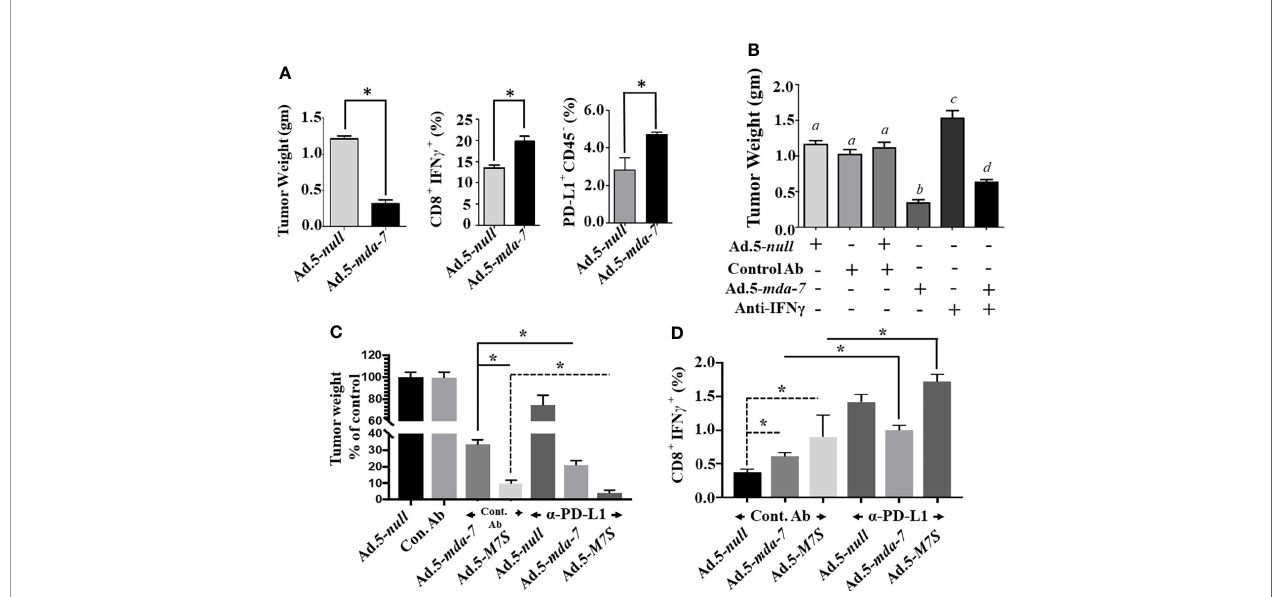
FIGURE 8 | Ad.5- M7S and anti-PD-L1 synergistically suppress murine B16 melanoma xenograft growth. (A) (Left Panel), Effect of MDA-7/IL-24 on B16 tumor growth in C57BL/6 animals. 5 X 10 5 B16 cells were injected subcutaneously in C57BL/6 mice and infected with Ad.5- null or Ad.5- mda-7 (intratumoral injection 10 8 viral particles, 3X in a week, 6 injections in total). Tumor weight was measured. Data presented is the average weight on day 14 from 5 mice from each group. Middle Panel, Cytotoxic T cell accumulation in the tumor. Right panel, PD-L1 expression in the cells isolated from tumors treated with Ad.5- mda-7 . Immunostaining protocol is described in Materials and Methods. (B) Effect of IFN- g neutralization on the therapeutic effect of mda-7 on B16 tumor growth. Experimental protocols are described in Materials and Methods. Different letters among variables indicate statistical signi fi cance. (C) Effect of combinatorial therapy of Ad.5-mda-7 or Ad.5-M7S plus anti-PD-L1 on B16 tumor growth. 5 X 105 B16 cells were injected subcutaneously in C57BL/6 mice and infected with Ad.5-null or Ad.5-mda-7 or Ad.5-M7S (intratumoral injection 108 viral particles, 3X in a week, 6 injections in total). For Anti-PD-L1, 100 m g of antibody was injected in PBS through the intraperitoneal route (3X in a week, 6 injections in total). Mice were sacri fi ced on day 14 after the fi rst therapeutic injections. Tumor weight was measured. Data presented is the average weight from 5 mice from each group. (D) CD8 + IFN- g expression in tumors are shown. *Statistical signi fi cance (p < 0.05).